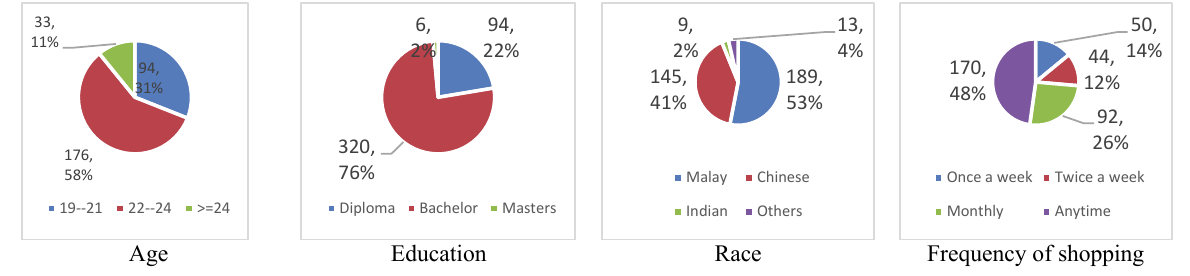
Fig. 2. Personal characteristics of the